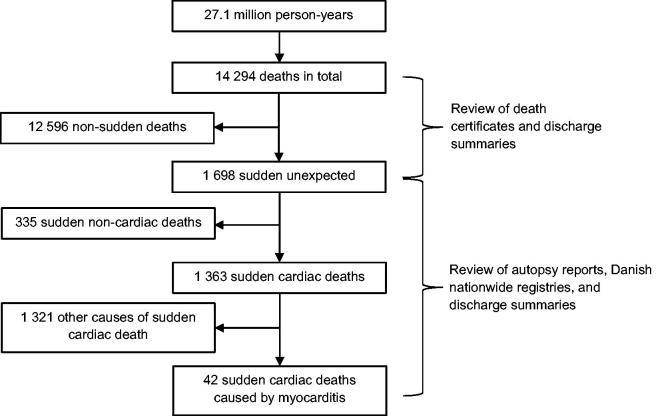
Flowchart of the process used to identify all cases of sudden cardiac death caused by myocarditis in persons aged 1–35 years and 1–49 years during 2000–2006 and 2007–2009, respectively.